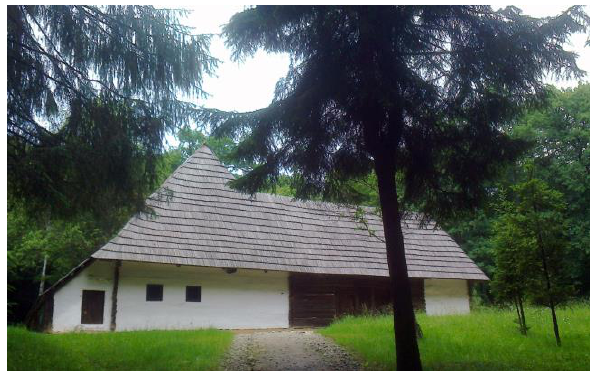
Figure 3. Shepherds’ “ocol” from Măgura, 1844